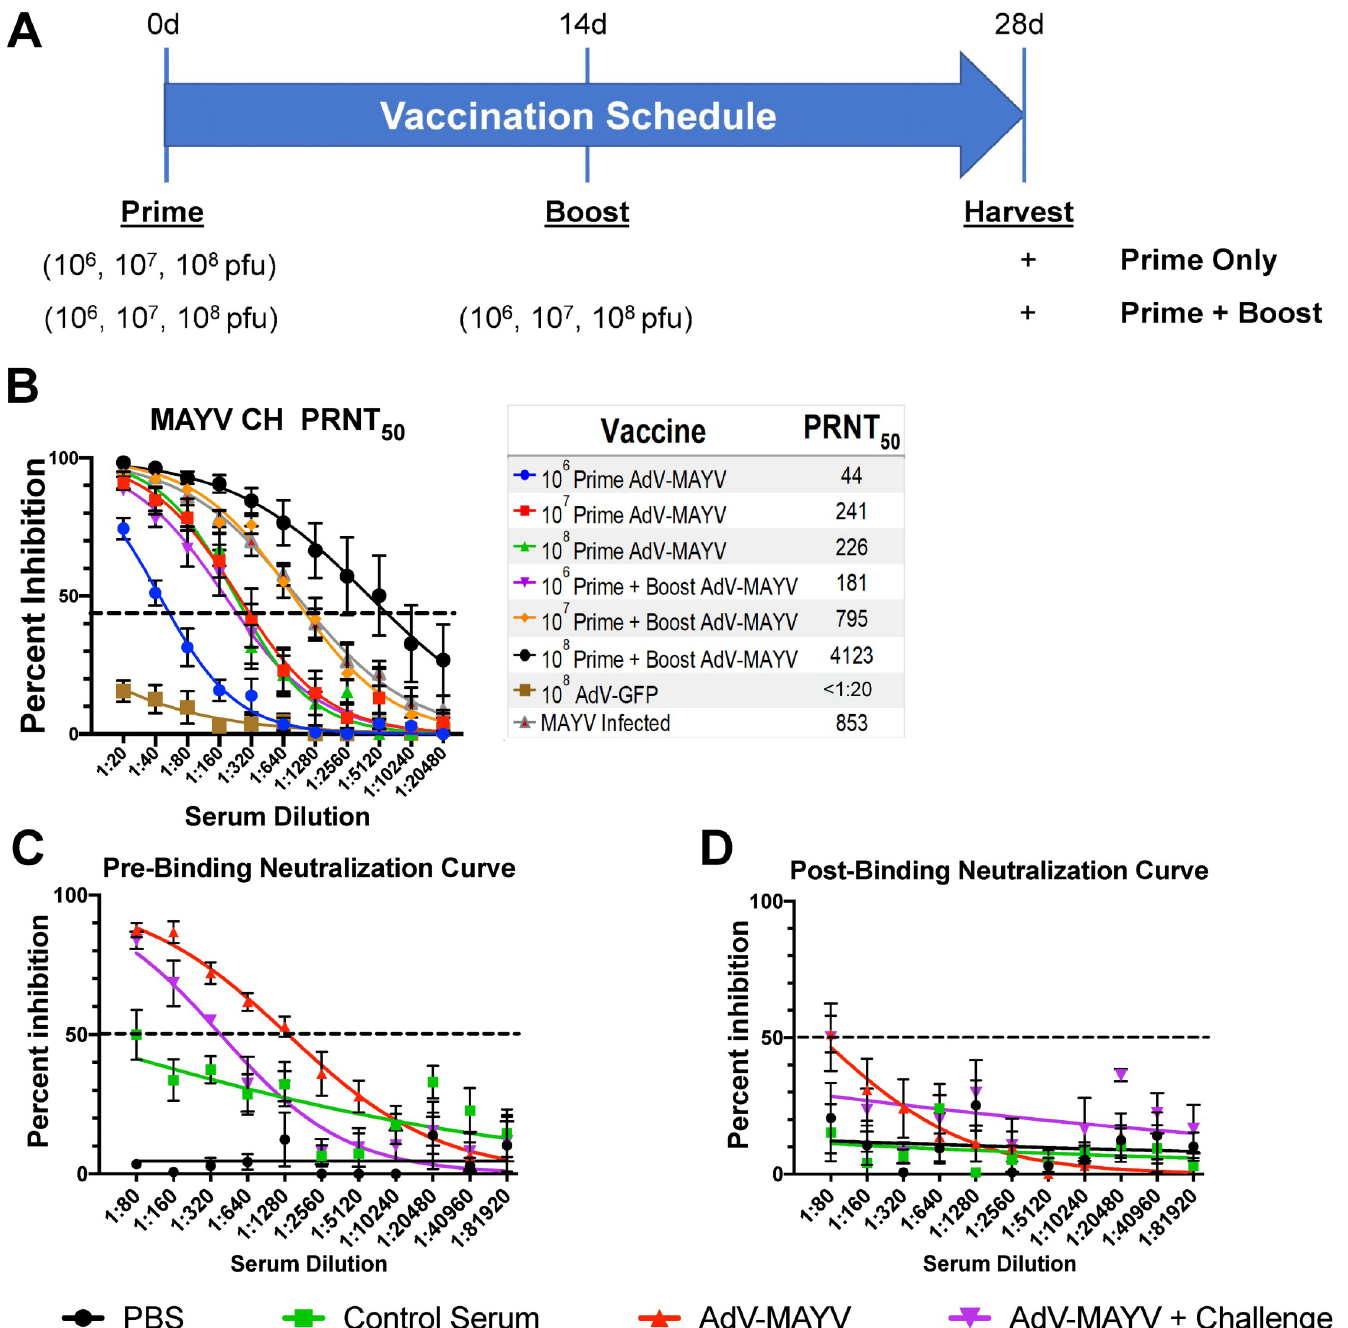
Fig 2. AdV-MAYV-Induced Antibody Response Neutralize Virus in A Pre-attachment Mechanism. (A) WT C57BL/6N mice were vaccinated with 10 6 , 10 7 , or 10 8 PFU AdV-MAYV by intramuscular injection (n = 5 mice per group). A separate group of animals were infected with 10 4 PFU MAYV BeAr . At 14 days post vaccination, a subgroup of mice received a vaccine boost with the same vector and dosage as was used during the primary vaccination. Blood was collected from the vaccinated mice at day 28. (B) Sera from each mouse was tested for MAYV CH neutralization potential using a PRNT 50 assay. Shown are the average PRNT 50 values calculated for each group by non-linear regression at a 95% confidence interval (n = 5 mice per treatment group). PRNT50 values were calculated by variable slope non-linear regression. (C and D) Pre- and post-attachment neutralization assays were performed to explore the mechanism of inhibition. For pre-attachment neutralization assays, aliquots of a known concentration of virus were mixed with serial dilutions of serum for one hour prior to application to a confluent monolayer of Vero cells. For post-attachment treatments, virus was incubated with Vero cells at 4˚C for one hour to allow binding and then serial dilutions of antibody were added for one additional hour at 4˚C. Triplicate biological replicates and representative curves determined by variable slope non-linear regression are shown. Error bars represent SEM representative of 4 biological replicates.